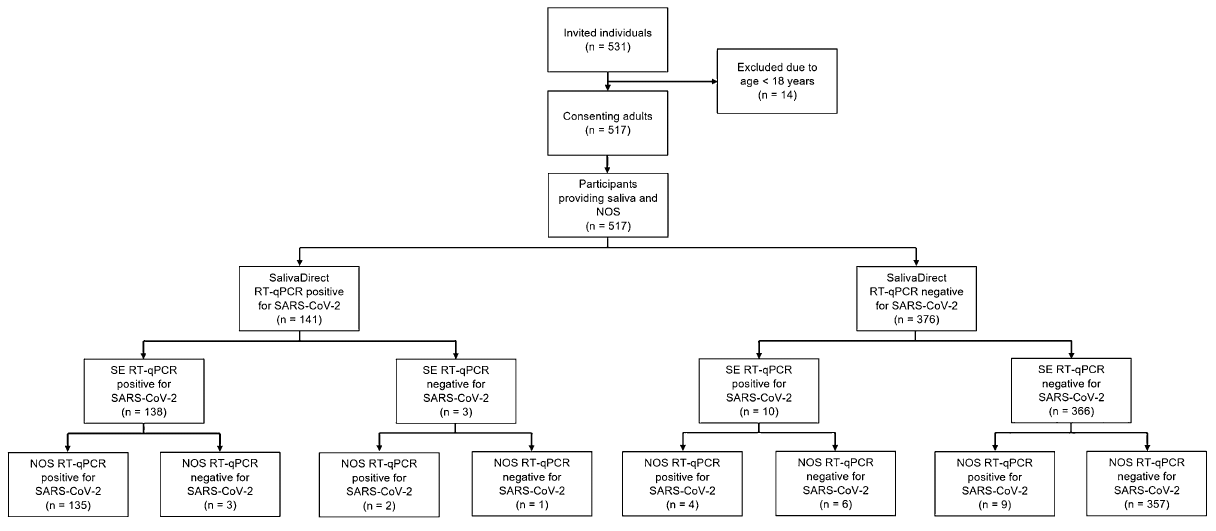
Figure 1. Flow diagram of participants in the study. NOS naso-oropharyngeal swab, RT‑qPCR reverse transcription quantitative/real-time polymerase chain reaction, SARS‑CoV‑2 severe acute respiratory syndrome coronavirus 2, SE saliva with RNA